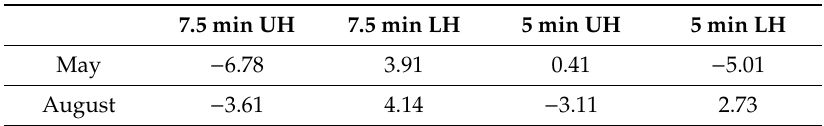
Table 3. Mean of relative di ff erence in flux ((simulated–AGM) / AGM) in percentage. UH and LH refer to starting simulation in upper or lower